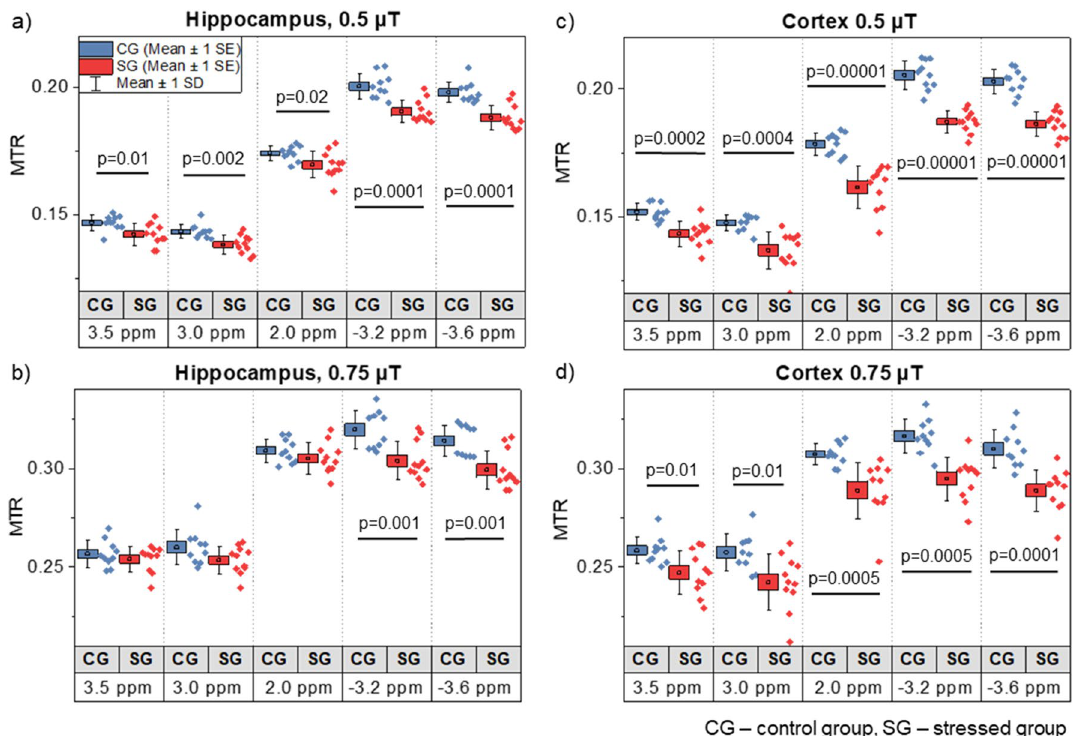
Figure 3. Comparison of magnetization transfer ratio (MTR) measured between groups in ( a , b ) hippocampus and ( c , d ) cortex with saturation B 1 s of 0.5 and 0.75 µT at frequency offsets of 3.5, 3.0, 2.0, − 3.2 and − 3.6 ppm. Statistically significant results are denoted by p-values derived from two-tailed Student’s